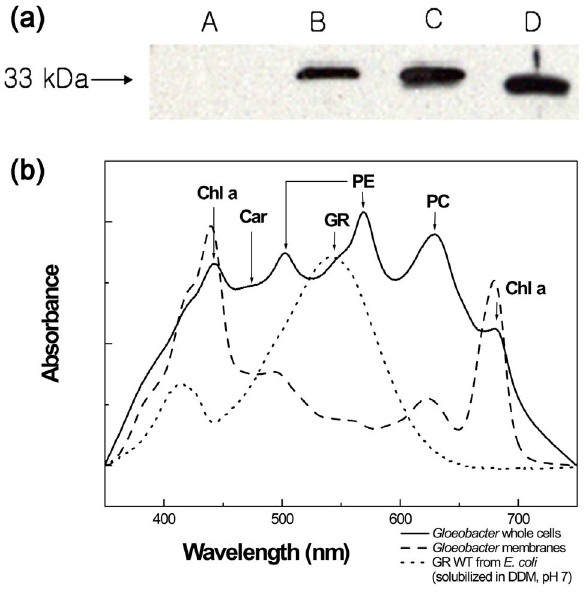
Figure 4. Immunoblot and spectroscopy analysis. (a) Immuno- blot analysis of the Gloeobacter cells and the His-tagged GR protein. The immunoblot used anti-GR antibody for the membrane protein fraction of Gloeobacter cells and anti-His-tag antibody for the protein expressed in E. coli . The whole cells (C) were sonicated and lysates were ultracentrifuged. The lysates were separated into supernatant (A: soluble protein) and pellet (B: membrane protein). D: purified GR from E. coli . (b) Absorption spectra of intact cells and membranes of G. violaceus . The spectrum of G. violaceus is shown with solid line. Chl a (chlorophyll a), Car (carotenoid), PE (phycoerythrin), GR, and PC (phycocyanin) are marked by the arrows. The spectrum of G . violaceus membrane is shown by the dashed line. The spectrum of purified GR in 0.02% DDM, isolated from E. coli is shown by dotted line.